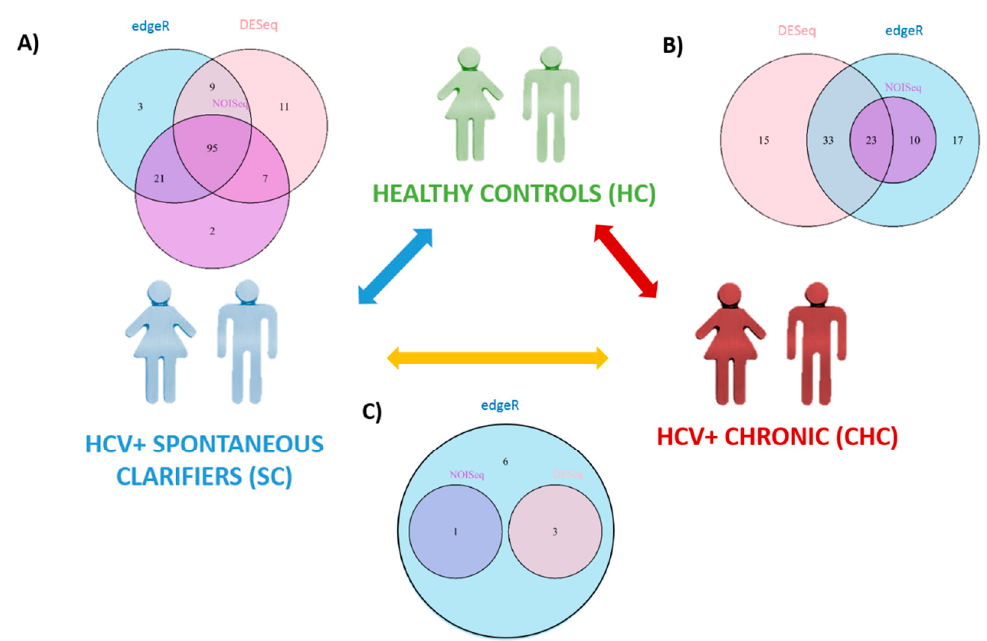
Figure 2. Statistically significant differentially expressed (SDE) miRNAs calculated by different methods of analysis—DESeq circles in pink, edgeR circles in blue, and NOISeq circles in purple—between each group of study: HC, SC, and CHC. Venn Diagrams show common SDE miRNAs in each analysis. ( A ) SDE miRNAs between HC and SC; ( B ) SDE miRNAs between HC and CHC patients; and ( C ) SDE miRNAs between SC and CHC patients.